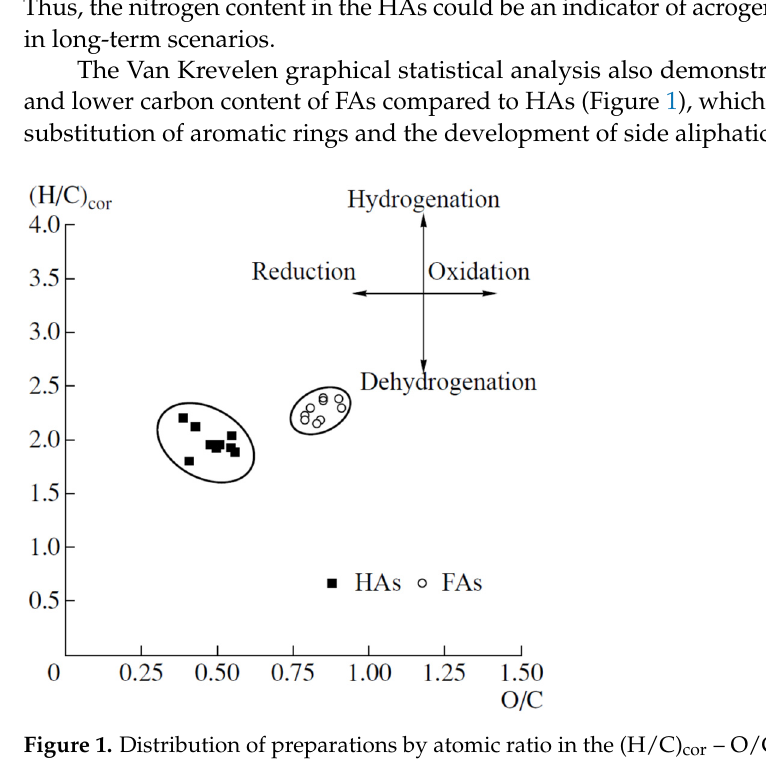
Figure 3. Relative content of structural fragments in HAs from mature and arable Retisols: aliphatic –CH, –CH 2 , and –CH 3 groups (1); amino group C and –O–CH 3 structures (2); carbohydrate, alcohol, and ether –C–O groups (3); aromatic C (4); phenol C Ar –O (5); –COOH groups (6); quinone C Ar =O (7) and aldehyde and ketone –C=O groups (8). When comparing the data on the structure of HAs from mature and arable Eutric Albic Retisols (Loamic) (Figures 2 and 3), a relative decrease in the total amount of ali- phatic chains accompanied by an 8.4% increase in the content of aromatic structures should be noted, which subsequently leads to an increase in the Σ C Ar / Σ C AL ratio in arable soil by half. It was found that plowing results in a decrease in –C–O groups of alcohols, ethers, and carbohydrates in the structure of HAs. It is explained by the fact that agricul- tural use enhances microbiological activity, which in turn leads to the destruction of the easily hydrolyzable part of HS consisting mainly of carbohydrate fragments [26]. The findings of the elemental analysis of the HAs from the arable Eutric Albic Retisol (Loamic) also confirm that agricultural development leads to an increased proportion of aromatic fragments, which is expressed as a lower (H/C) cor ratio compared to the mature soil samples (Table 3). Literature data also indicate a significant transformation of the car- bon skeleton of HA macromolecules manifested in a relative increase in the total content of aromatic structures as a result of agricultural use [5,22,35].